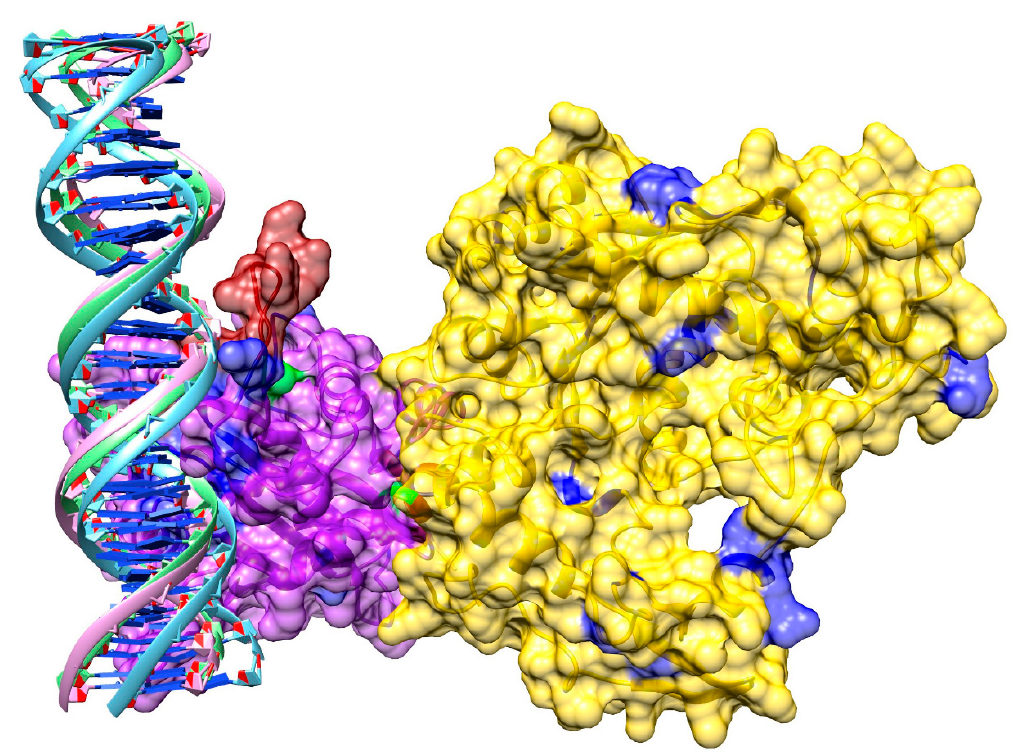
Figure 9. Model of pUL15 complexed with dsDNA. The N-terminal of the protein is yellow, and the C-terminal is purple. DNA binding residues predicted with DISPLAR (blue), DP-Bind (red) and both programs (green) are shown.